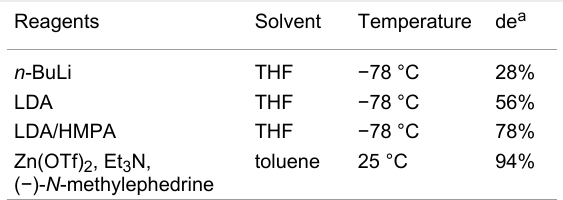
Table 1: Asymmetric alkynylation with